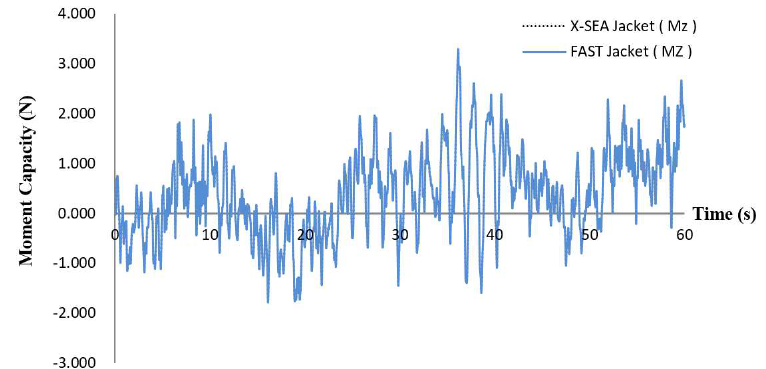
Figure 10. Comparison of the dynamic vertical reaction moment capacity on the jacket support structure about the z-direction resulted from X-SEA and FAST v8 programs.